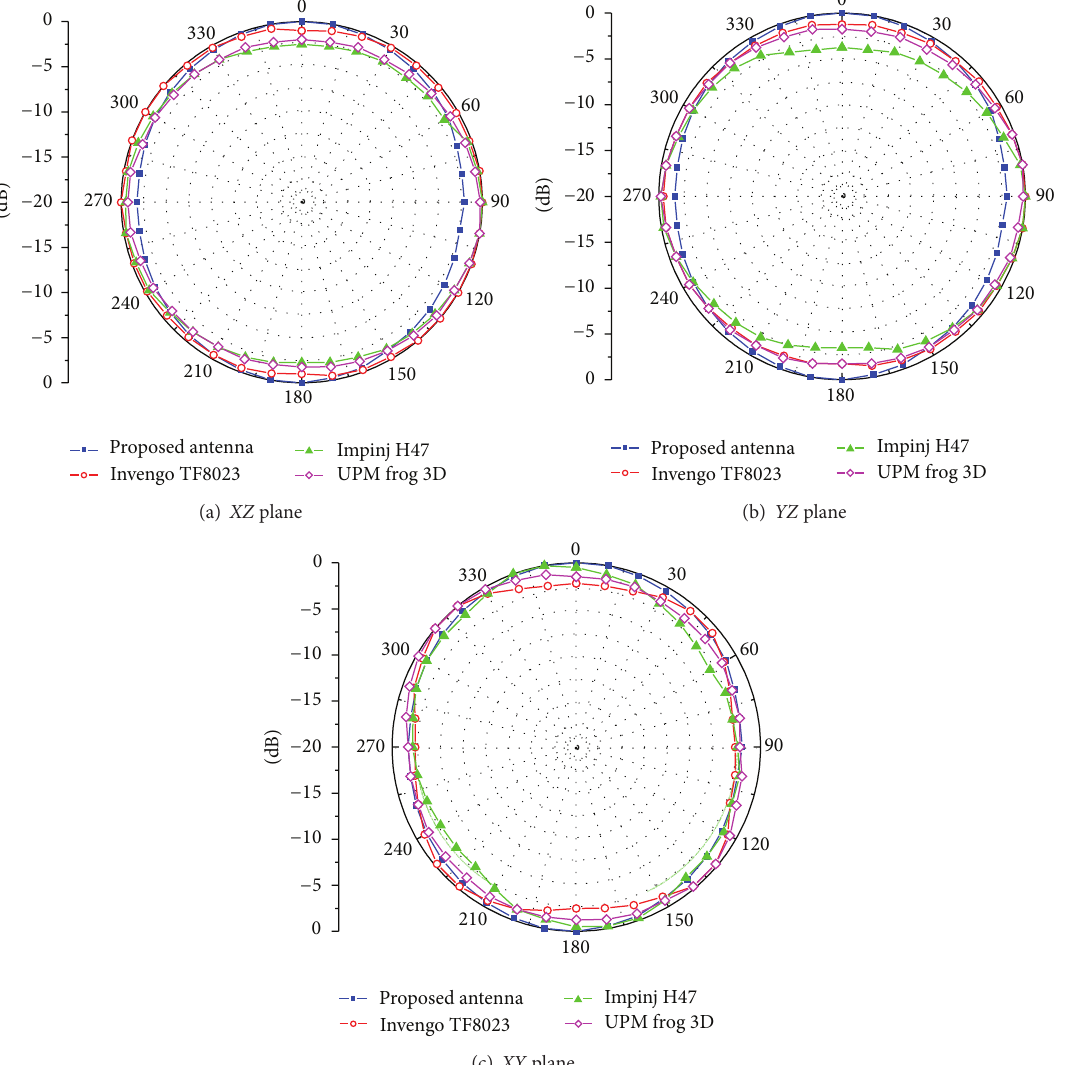
Figure 11: Measured normalized radiation patterns of the four kinds of tag antennas.